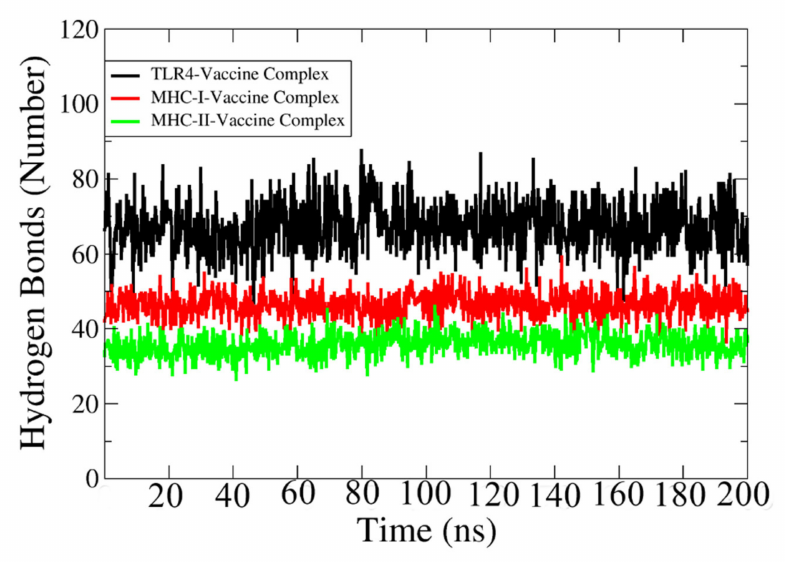
Figure 10. Number of hydrogen bonds between TLR-4, MHC-I, and MHC-II with designed vaccine